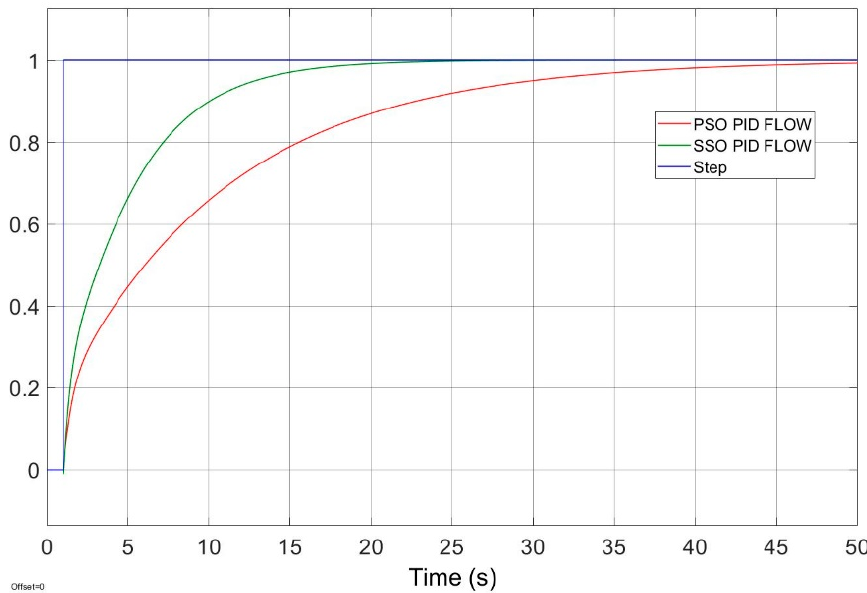
Figure 18. Flow versus time plot for PID tuned with PSO and SSO. Appl. Sci. 2020 , 10 , x FOR PEER REVIEW